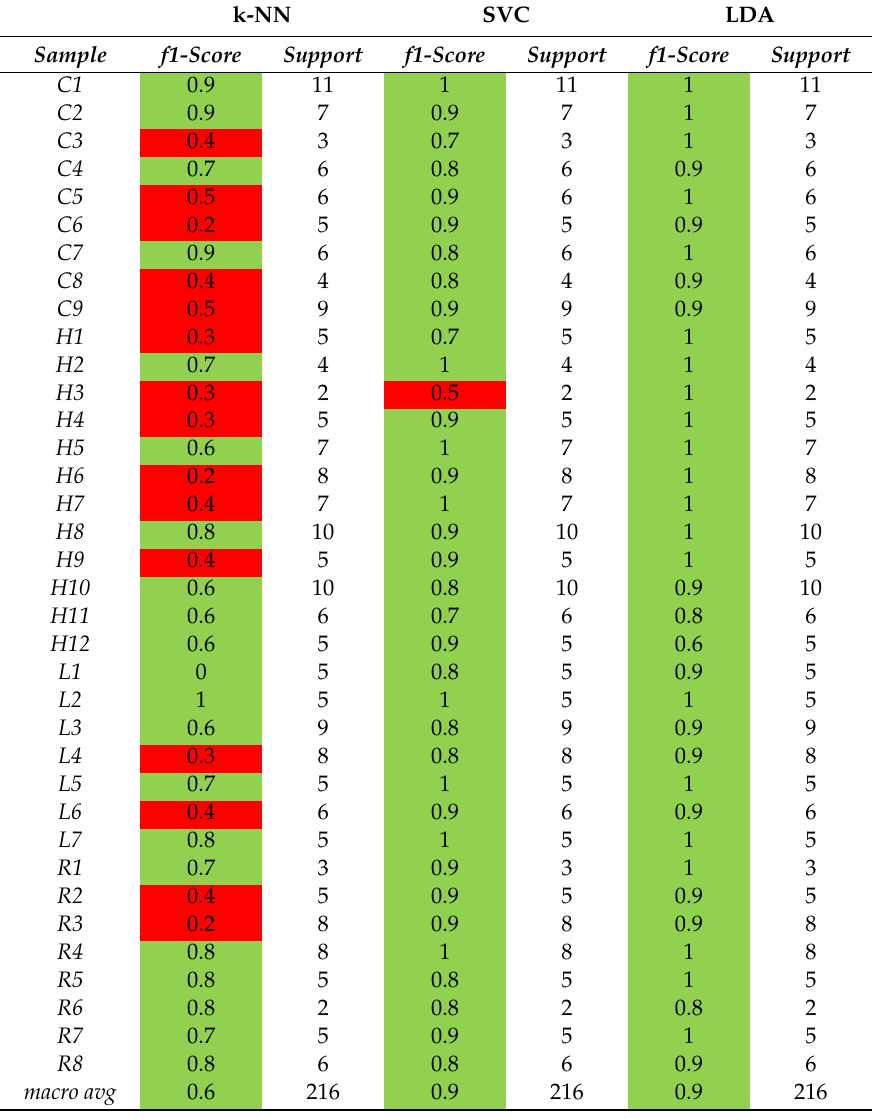
Table 2. Classification report for PCA-preprocessed k-NN, SVC and LDA